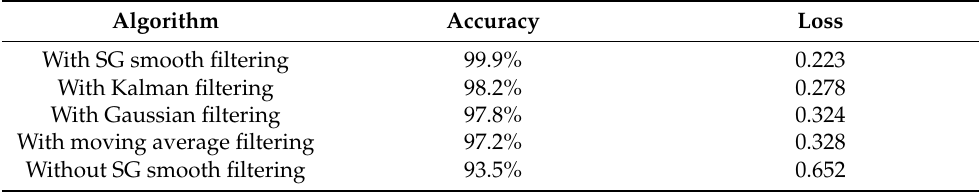
Table 5. The experimental results contrast.